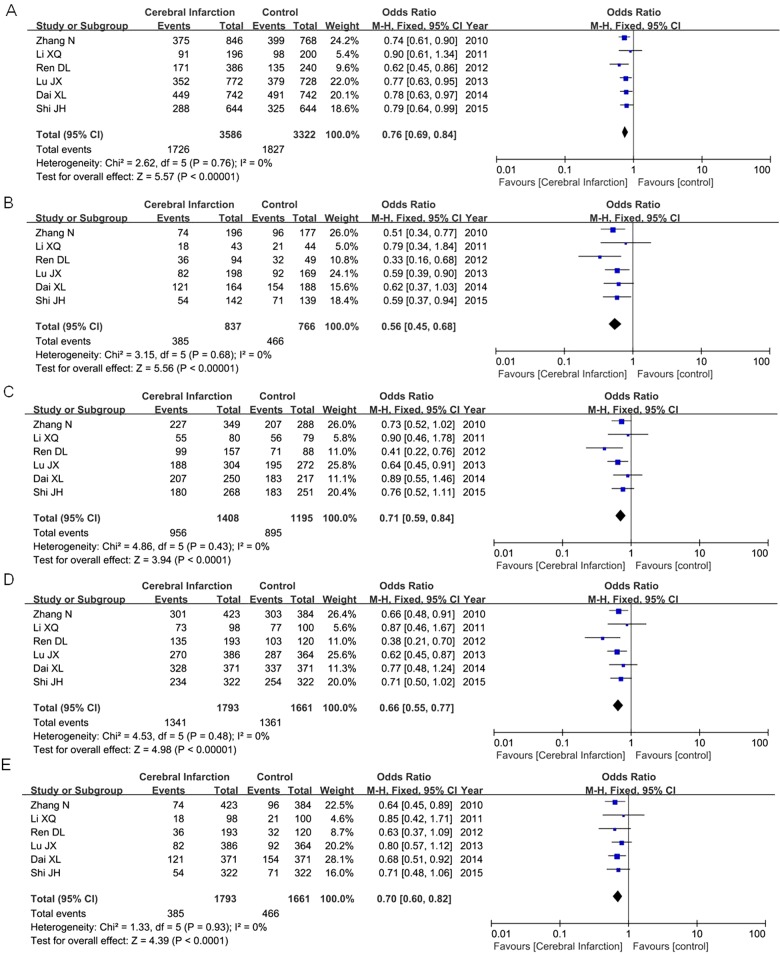
Forest plots for association between IL-18 −607C/A polymorphism and cerebral infarction risk under the allelic model (A), homologous model (B), heterogeneous model (C), dominant model (D) and recessive model (E).